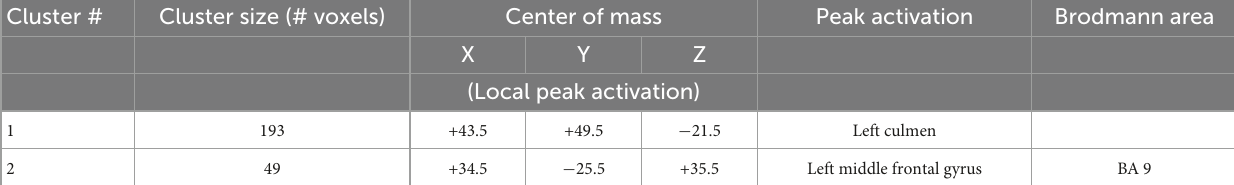
TABLE 4 Regions with significant sex effect in MDD group.